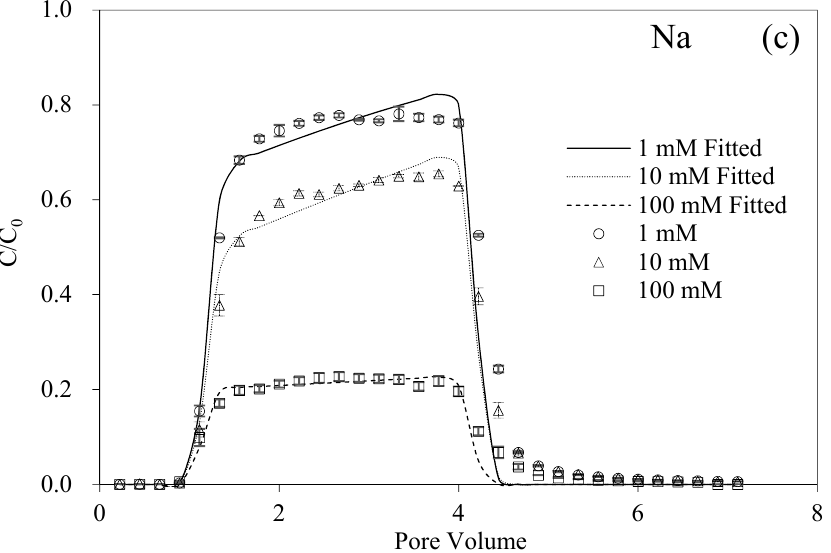
Figure 2. Breakthrough and fitting curves of BMBC at different ISs of Na with 0 ( a ), 1 ( b ), and 5 ( c ) mg L − 1 HA.